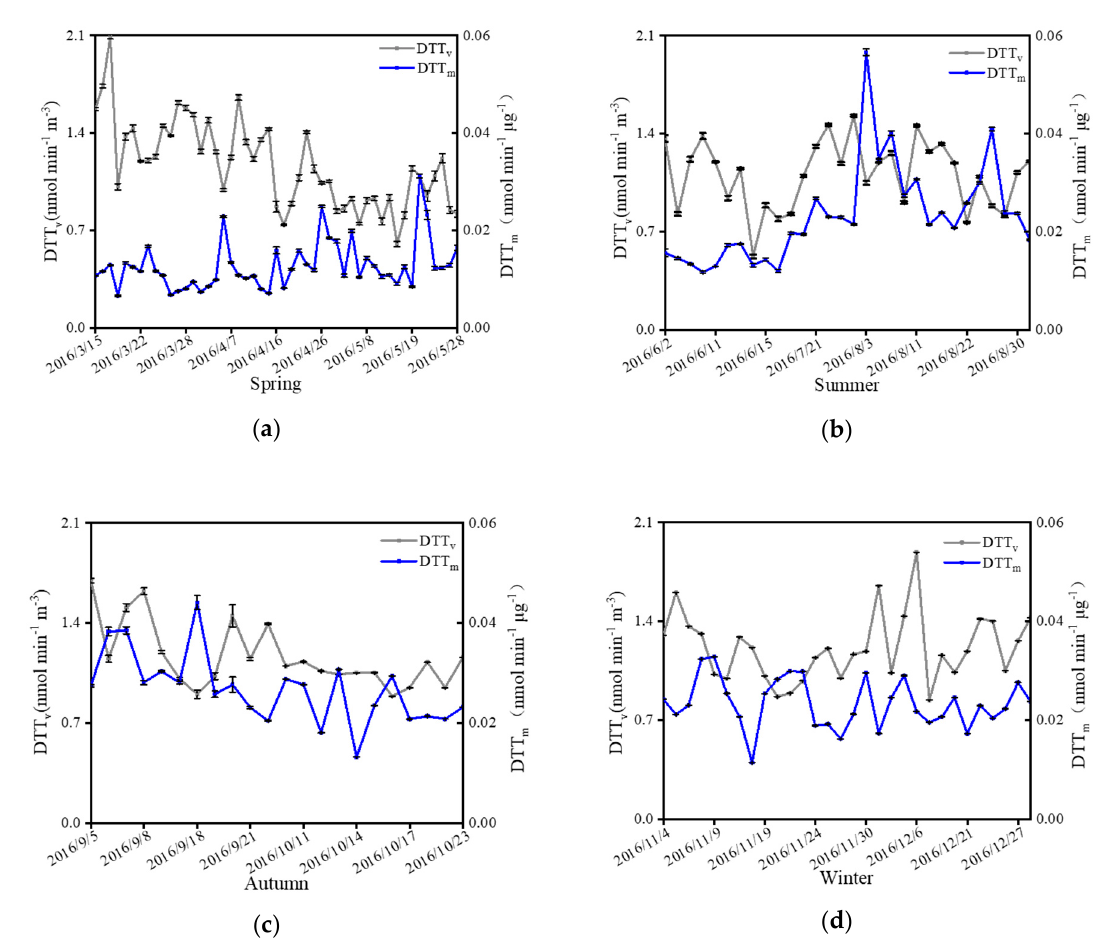
Figure 4. The DTT v and DTT m in Nanjing in spring ( a ), summer ( b ), autumn ( c ), and winter ( d ). A positive correlation between DTT v and PM 2.5 mass concentrations was